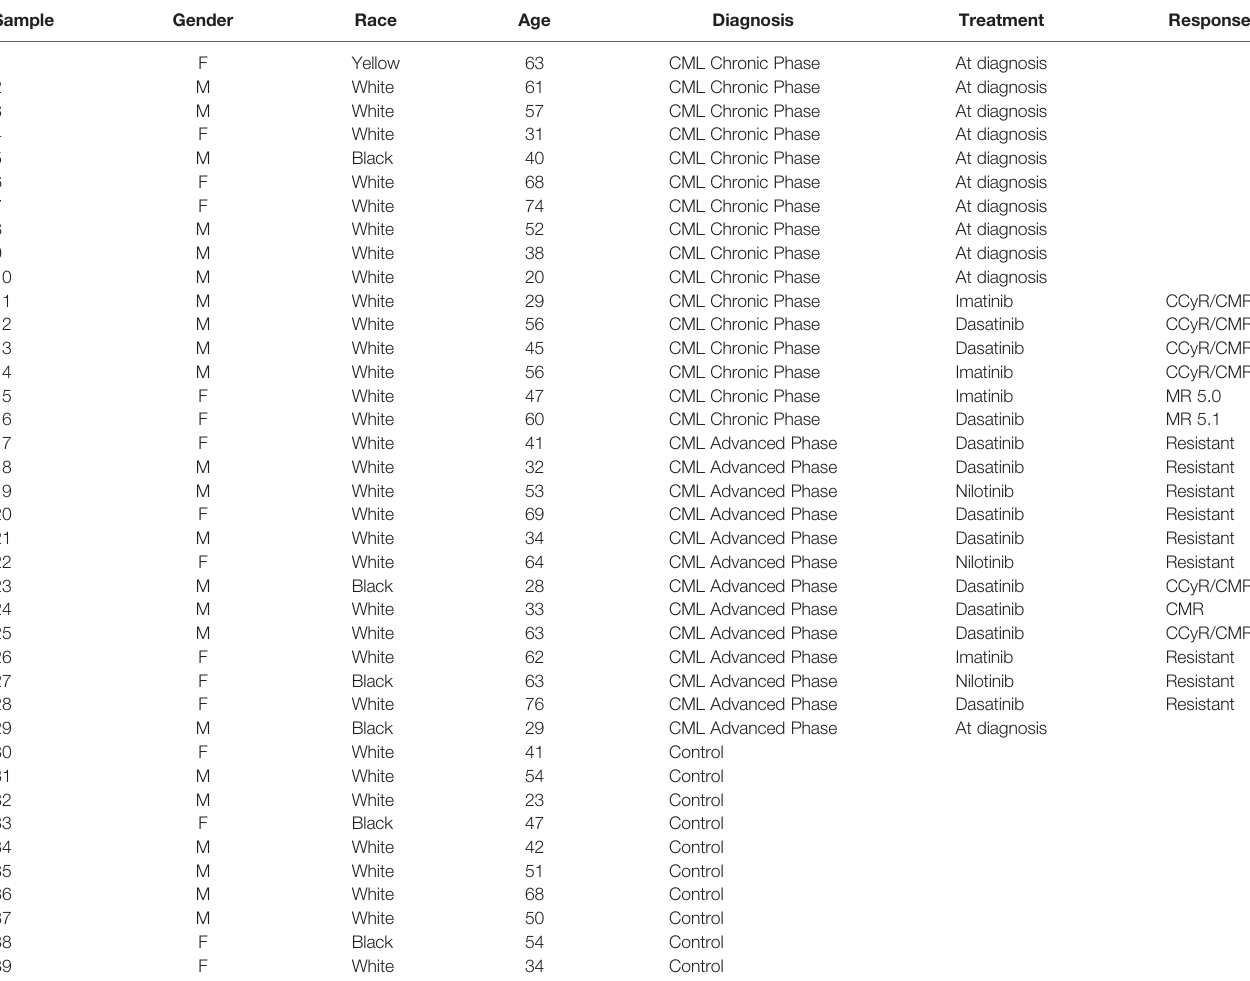
TABLE 1 | Clinical and socio-demographic features of CML patients and controls. Sample